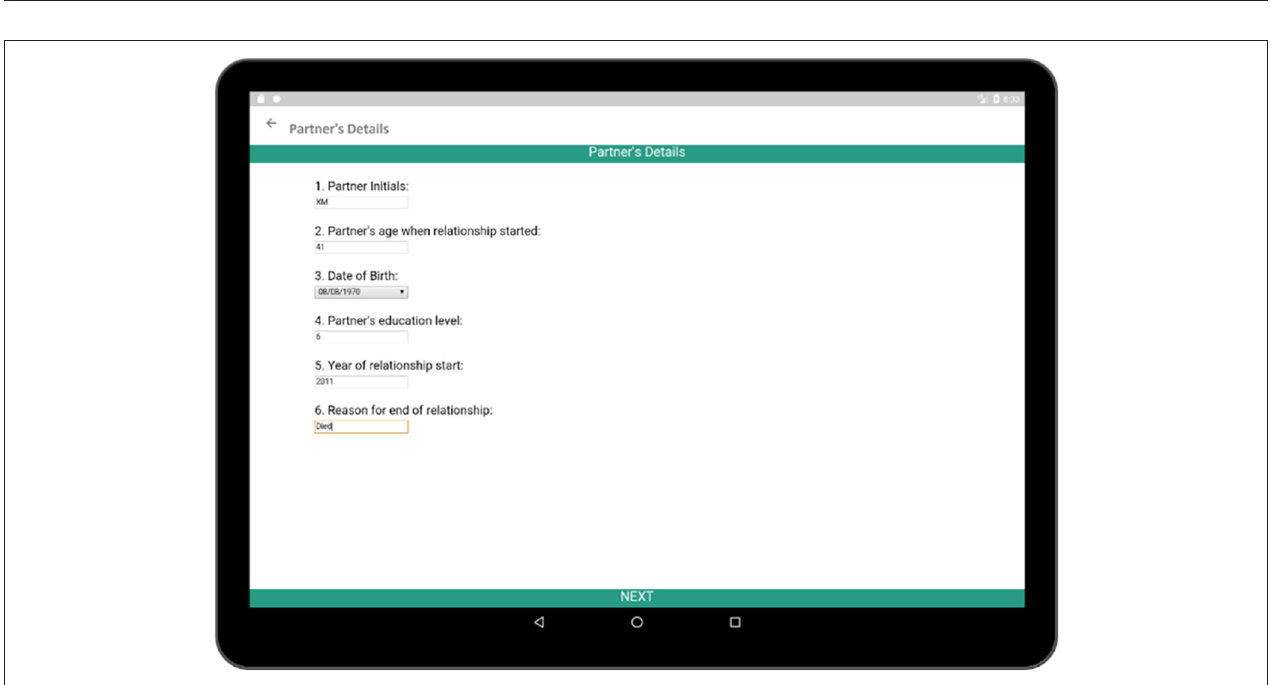
FIGURE 12 | Partner’s details (collects some information about the